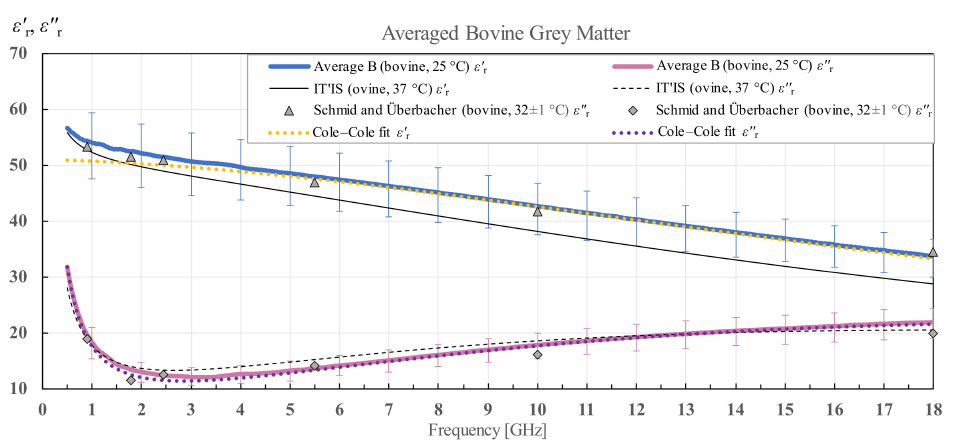
Figure 15. Permittivity of averaged bovine grey matter with standard deviation and Cole–Cole fit, in comparison with the data from IT’IS database [21] and Schmid and Überbacher [29].